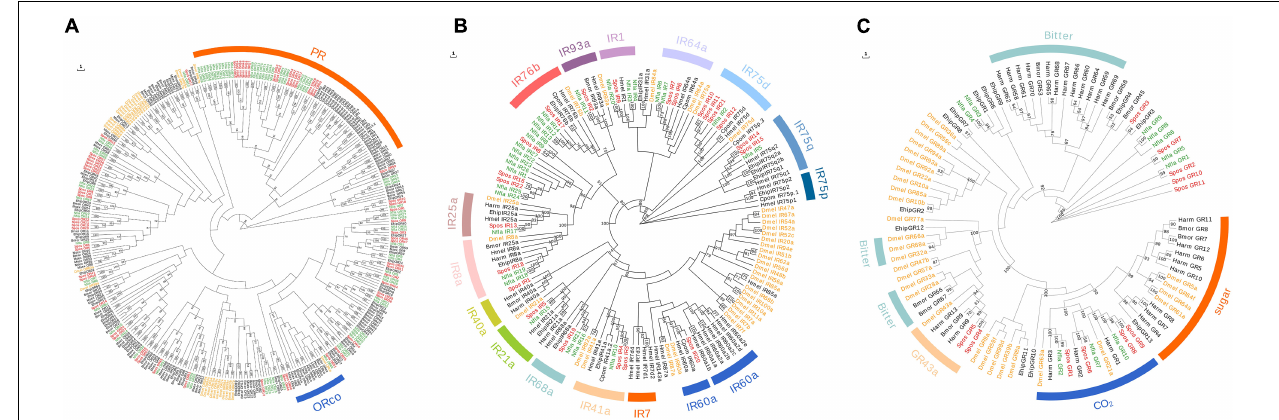
FIGURE 2 | Maximum-likelihood phylogenetic tree based on protein sequences of candidate odorant receptors (ORs) (A) , ionotropic receptors (IRs) (B) , and gustatory receptors (GRs) (C) . (A) The ML phylogenetic analysis of ORs of N. flavidorsalis (Nfla OR, green) and S. postornata (Spos OR red) were performed with reference ORs of D. melanogaster (Dmel OR, yellow) and ORs of Lepidoptera species (black). The orange arch refers to PR lineage, and the blue arch refers to ORco. (B) The ML phylogenetic analysis of IRs of N. flavidorsalis (Nfla IR, green) and S. postornata (Spos IR red) were performed with reference ORs of D. melanogaster (Dmel IR, yellow) and IRs of Lepidoptera species (black). (C) The ML phylogenetic analysis of GRs of N. flavidorsalis (Nfla GR, green) and S. postornata (Spos GR, red) were performed with reference GRs of D. melanogaster (Dmel IR, yellow) and GRs of Lepidoptera species (black). The stability of the nodes was assessed by bootstrap analysis with 1000 replications, and only bootstrap values ≥ 0.6 are shown at the corresponding nodes.